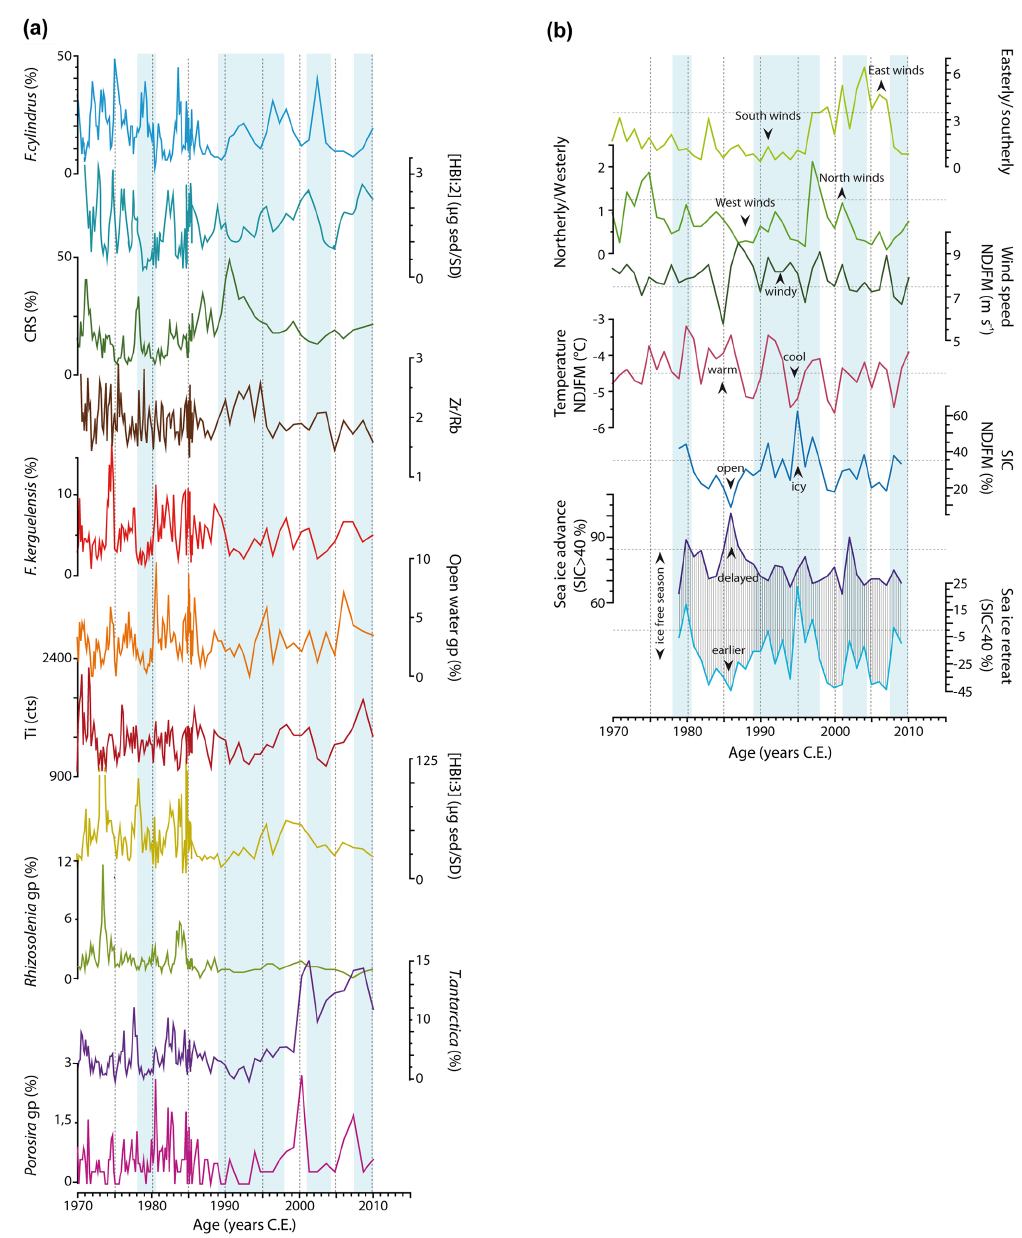
Figure 3. (a) Raw sedimentary records from DTCI2010 interface core over the 1970–2010 period. The blue shading indicates periods marked by increasing monitored sea ice concentration at the core site. (b) Meteorological parameters and climate index over the 1970–2010 period. Daily meteorological parameters were averaged over the November to March period. Blue shaded areas mark increases of SIC. Supplementary core data are available at: